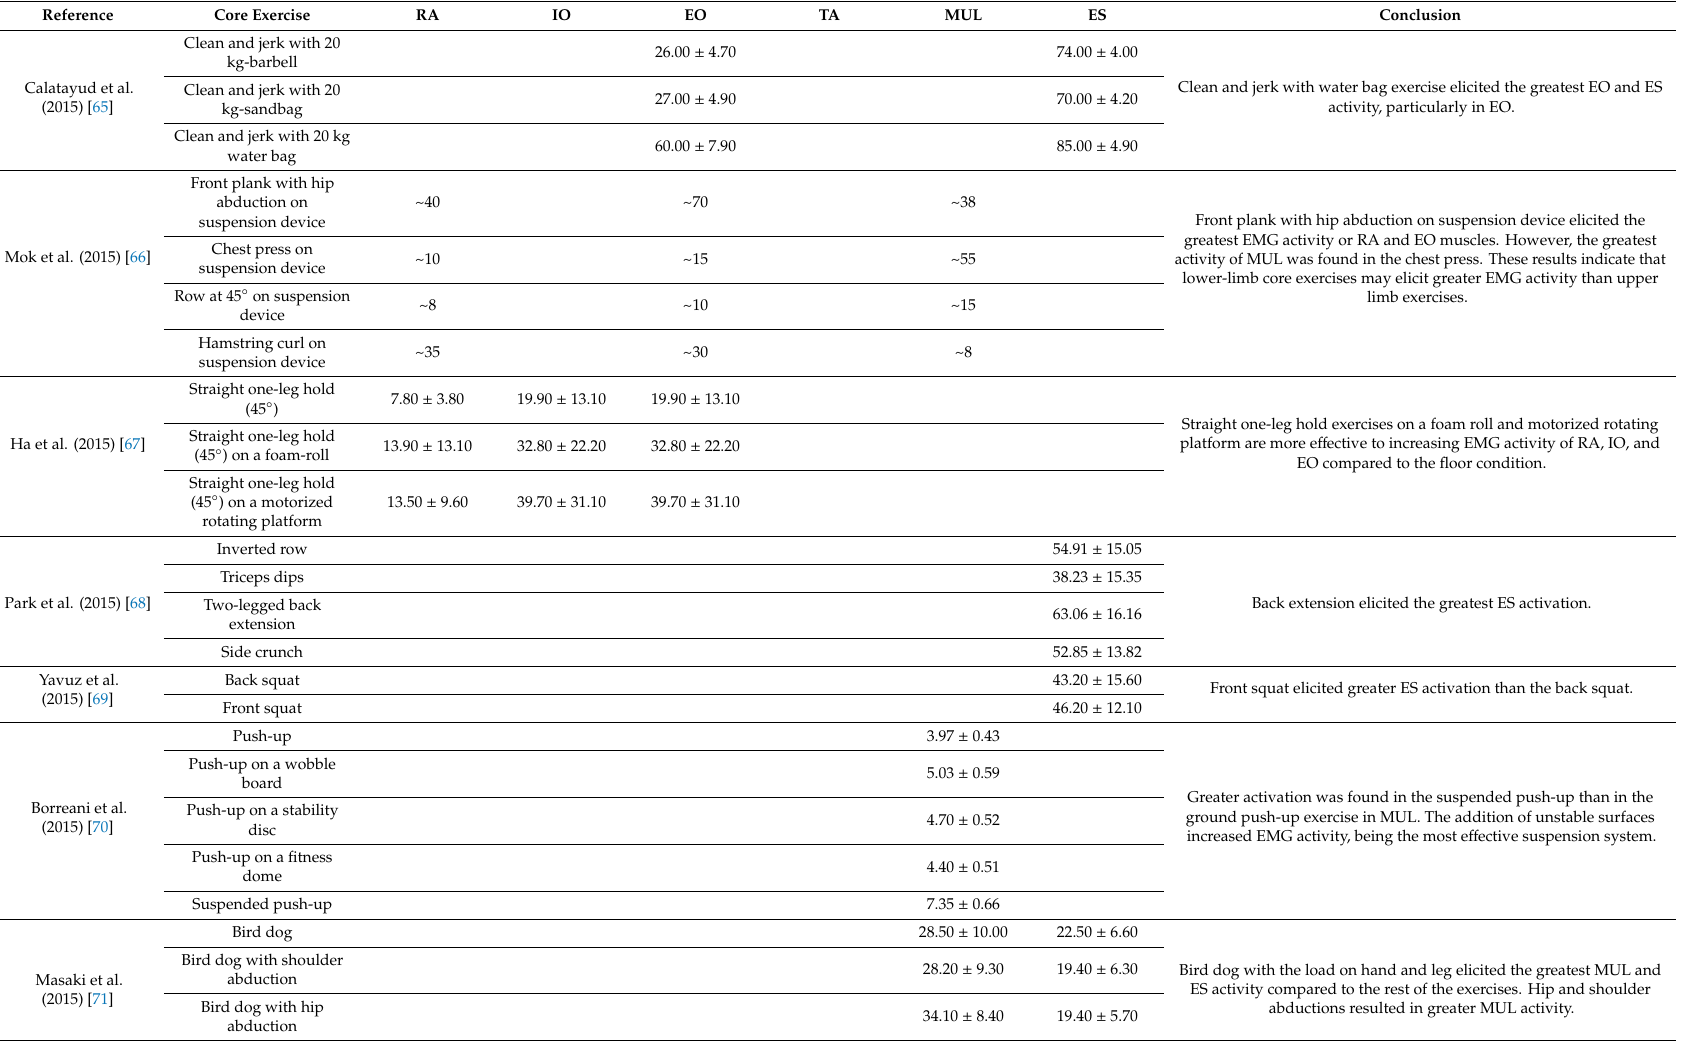
Front plank with hip abduction on suspension device elicited the greatest EMG activity or RA and EO muscles. However, the greatest activity of MUL was found in the chest press. These results indicate that lower-limb core exercises may elicit greater EMG activity than upper limb